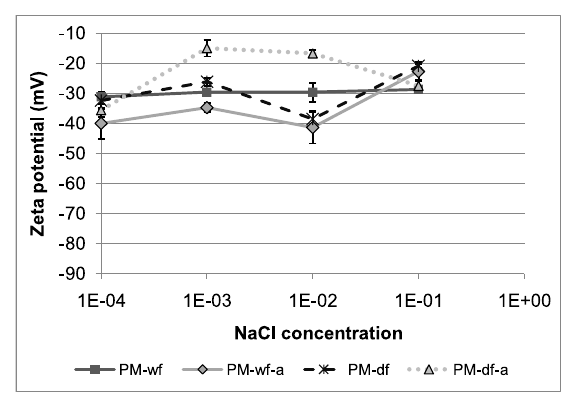
Figure 6. The effect of NaCl concentration on zeta potential of PM samples. The sample pHs: PM-wf 5.4–6.2, PM-wf-a 5.7– 7.1, PM-df 5.7–7.2, and PM-df-a